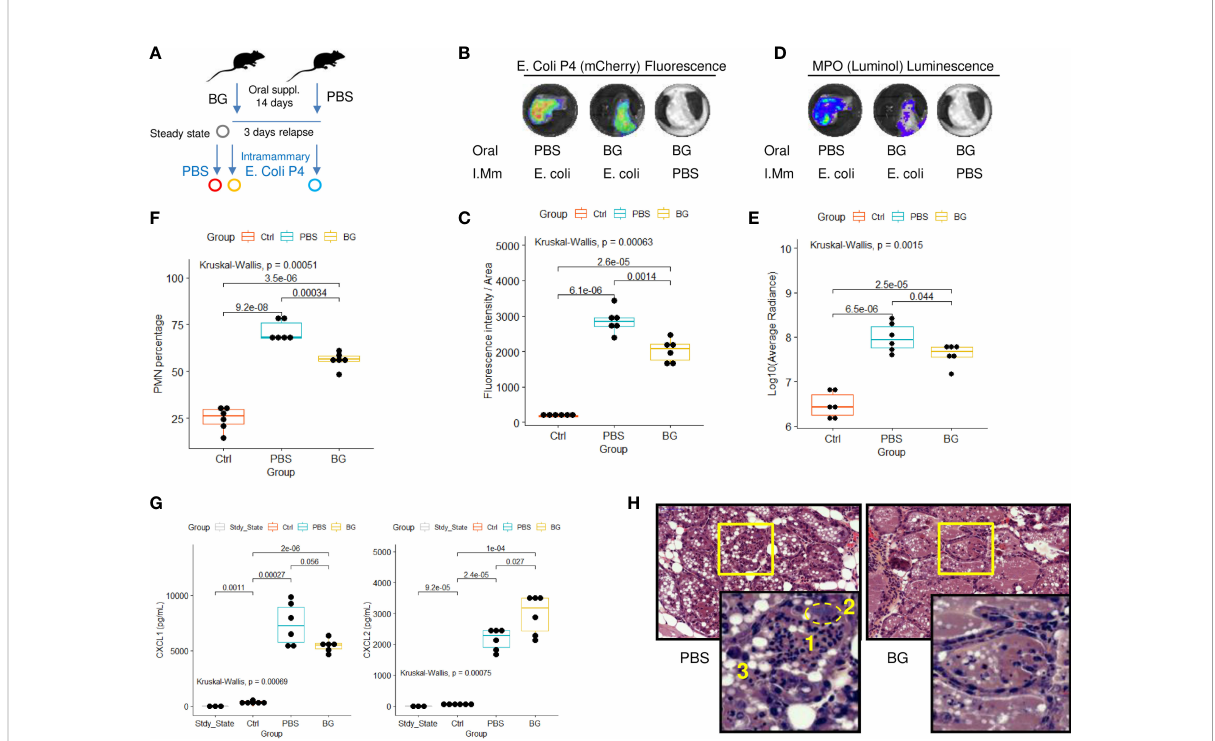
FIGURE 8 Intra-mammary infection with E . coli strain P4 in b -glucan- or PBS-supplemented mice. (A) Experimental design, for which the steady state corresponds to b -glucan mice euthanized after the supplementation period but with no intra-mammary injections (n = 3), Ctrl corresponds to b -glucan-supplemented mice that received a PBS injection in one mammary gland (n = 6 mice), b -glucan (n = 6) and PBS (n = 6) correspond to mice supplemented as indicated and infected intra-mammarily with E. coli P4. Ex-vivo imaging of (B, C) fl uorescence or (D, E)